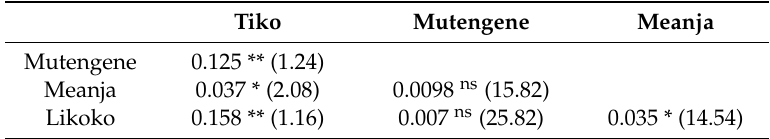
Table 4. Patterns of genetic di ff erentiation between An. funestus s.s. populations based on K ST estimates from Rdl mutation with